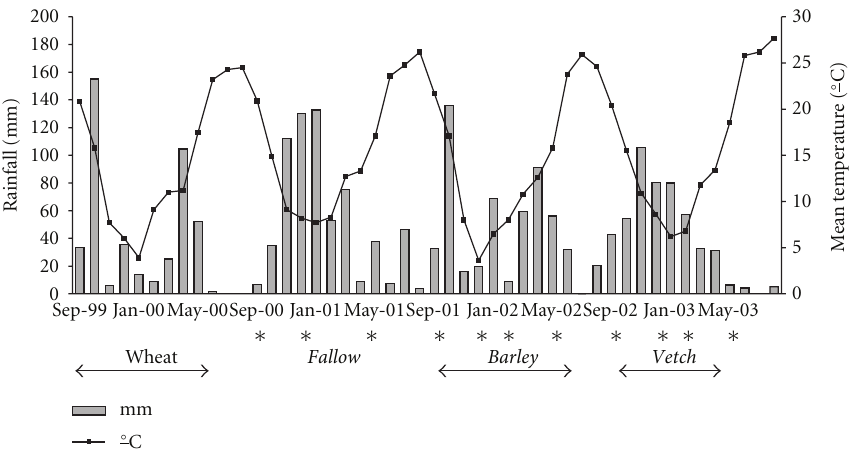
Figure 1: Distribution of rainfall and mean temperature during the field experiment. Crop rotation in the experimental parcels is shown (1999/2000–2002/2003). In italic the crop sequences considered in this study (2000/2001–2002/2003). ∗ Dates of soil